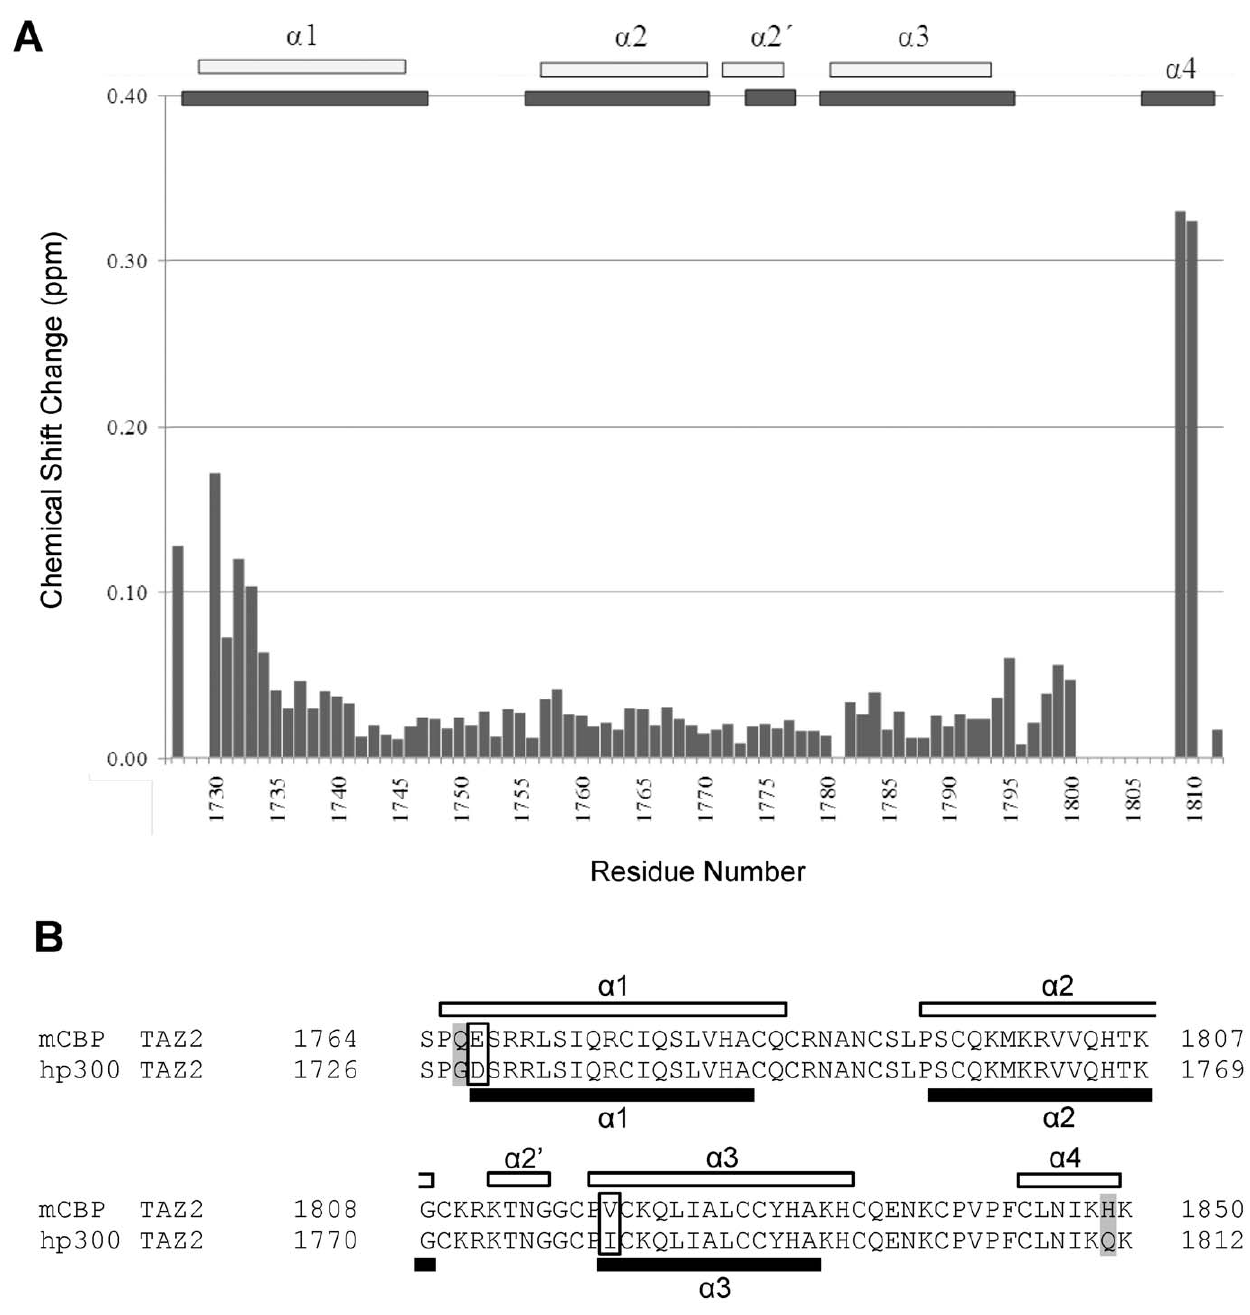
Figure 3. Comparison of NMR assignments and secondary structures for the TAZ2 domains of CBP and p300. Panel A summarises the combined differences in backbone amide ( 15 N and 1 H), CO and C a chemical shifts for equivalent residues in the TAZ2 domains of CBP and p300. To compensate for the increased chemical shift range of 15 N and 13 C compared to 1 H, the combined change was calculated as ( D 1 HN + ( D 15 N 6 0.2) + ( D 13 C a 6 0.1) + ( D 13 CO 6 0.35))/4. In a very few cases where some of the chemical shifts were not available, the sum of the chemical shift changes was divided by the number of available shift differences. Panel B shows an alignment of the very closely related TAZ2 sequences from CBP and p300. Conservative substitutions are highlighted in an open box and non-conservative highlighted in grey. The black bars shown indicate the positions of the helices in CBP TAZ2 [30], whilst the white bars represent the positions of the helices in p300 TAZ2, which were identified by analysis of the backbone resonance assignments using the chemical shift index method [45].